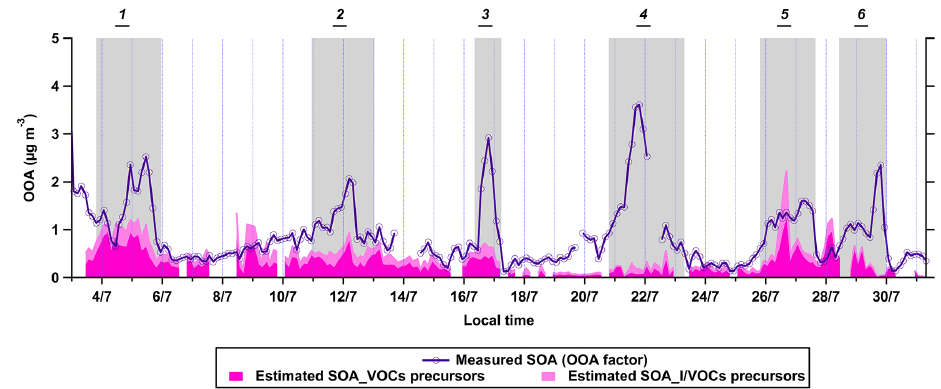
Figure 8. Temporal evolution of the OOA, or SOA, concentrations (µgm − 3 ) (1) observed at SIRTA, (2) estimated from the VOCs and (3) from the I / VOCs (i.e., VOCs + C 12 –C 16 IVOCs) measured at SIRTA using atmospheric-relevant SOA yields. The grey-shaded areas highlight the “Atlantic Polluted” wind regimes associated with stagnant conditions and increased